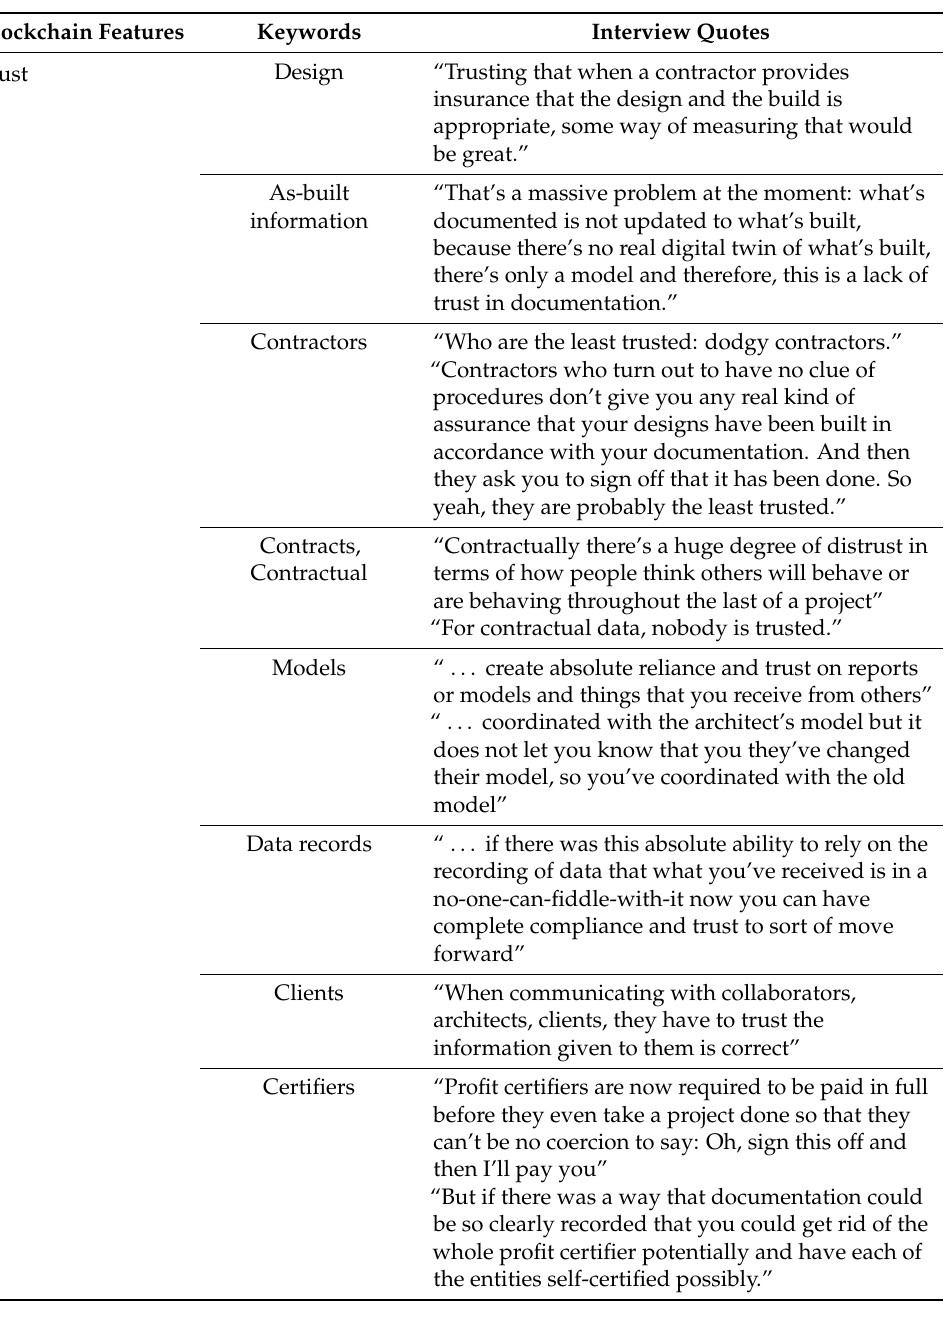
Table 9. Interview quotes in relation to the project lifecycle data categorization sub-theme. Blockchain